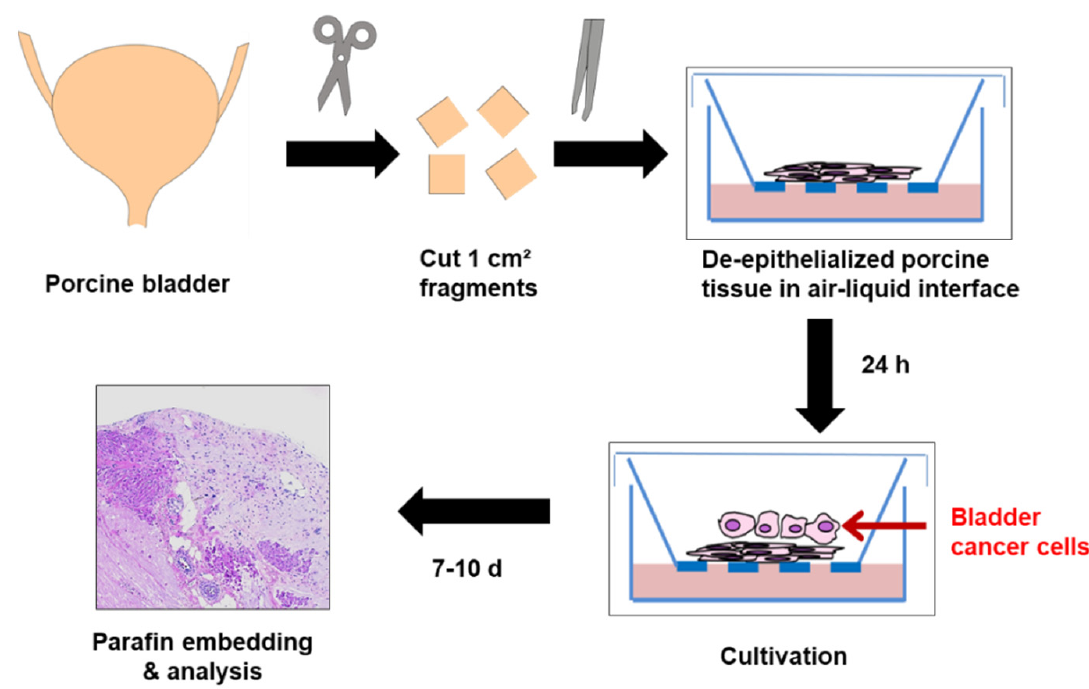
Figure 5. Schematic overview of ex vivo organ culture model for cell invasion. Porcine bladders were cut into 1-cm 2 pieces and tissue was processed for de-epithelization. Cells were placed onto the de-epithelialized porcine bladder pieces and kept for 7–10 days in an air–liquid-interface before analysis.